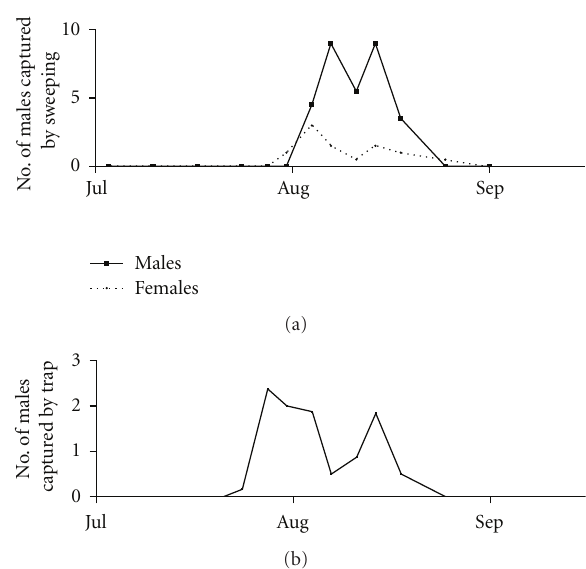
Figure 7: Comparison of the numbers of Stenotus rubrovittatus males caught by sweep-net sampling (a) or by a pheromone-baited sticky trap placed in the center of the paddy field (b). Sweep-net samples were taken 13 times at 7d intervals. Data were modified from